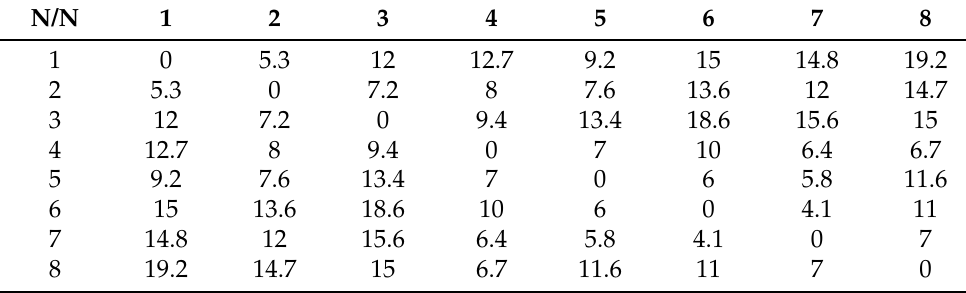
Table A5. Table representing matrix of distance between nodes dist n , m .